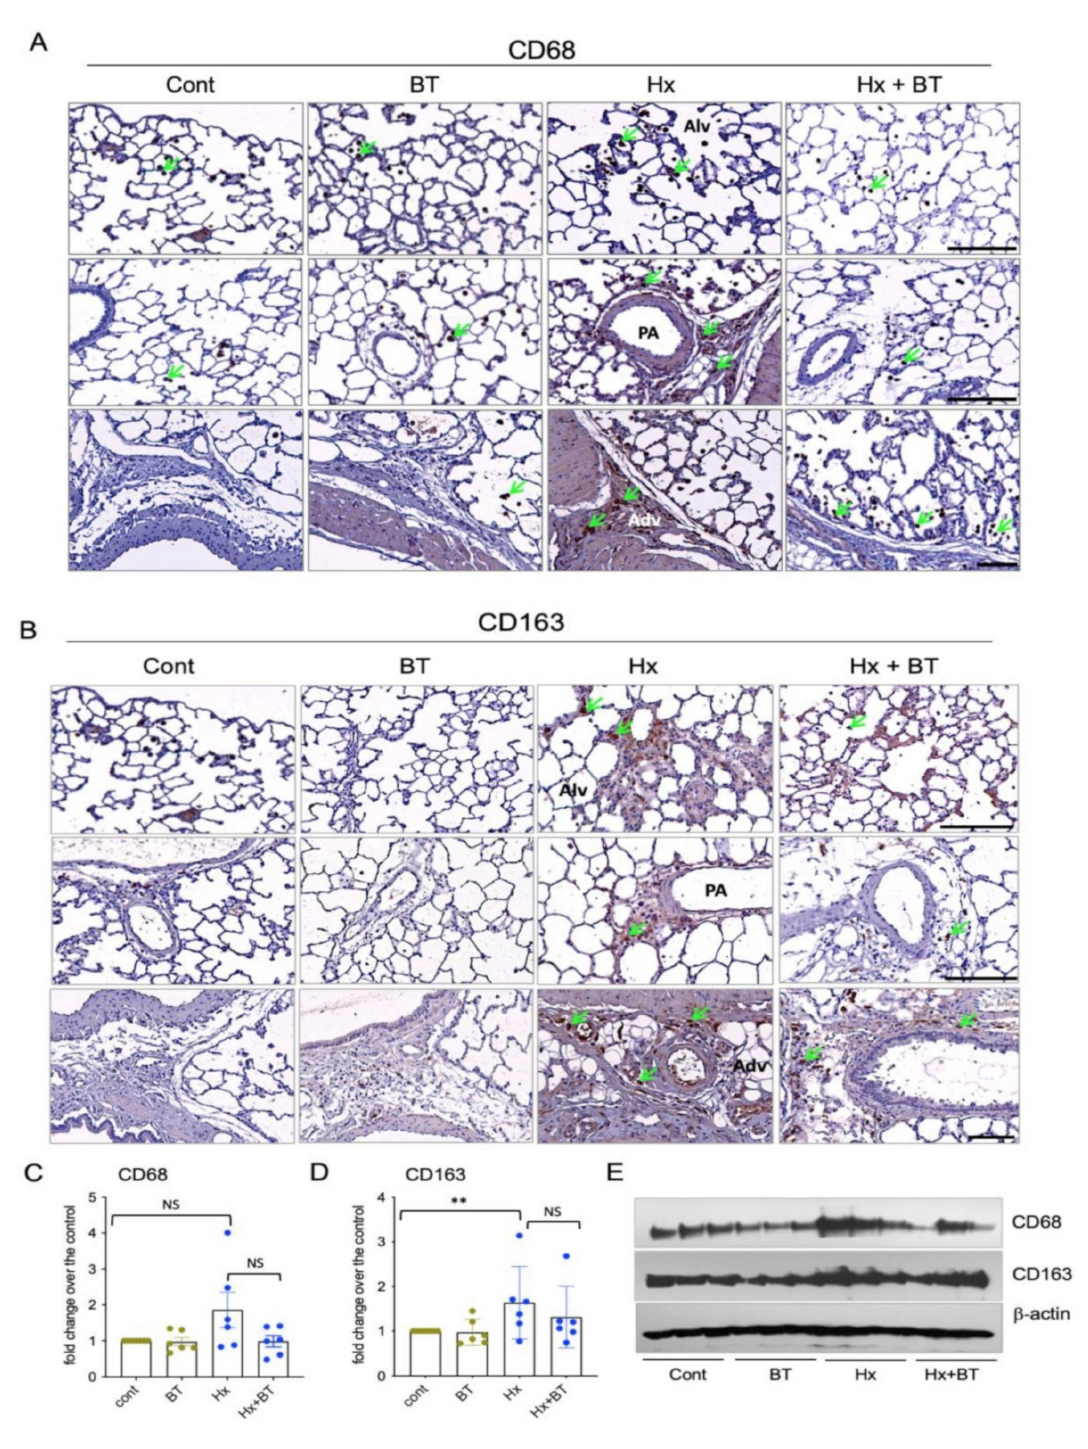
Figure 3. Hypoxia and butyrate modulate the level of macrophage accumulation in the lungs. ( A , B ): Lung sections from control (cont), butyrate-treated (BT), hypoxic (Hx), and butyrate-treated hypoxic (Hx + BT) animals were subjected to immunohistochemical analyses with anti-CD68 and anti-CD163. (The upper row on both panels shows lung alveoli (Alv), middle row shows distal pulmonary vessels (PA = pulmonary artery), and the lower row shows vascular adeventitia (Adv) and surrounding perivascular space), arrows indicate CD68+ and CD163+ macrophages; scale = 200 µ m on upper and middle panels, scale = 100 µ m on lower panels; ( C – E ): Western blot analysis of CD68 and CD163 expression in total lung lysates. Results are representative from six animals (n = 6) obtained from two independent experiments; data represent a mean +/ − SED; ** p < 0.01; NS = not